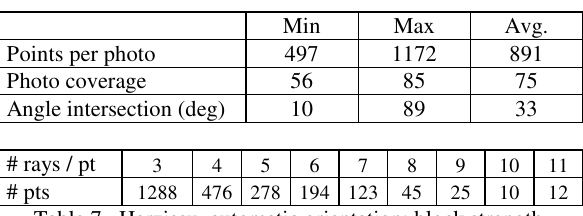
Table 7. Herzjesu, automatic orientation: block strength statistics